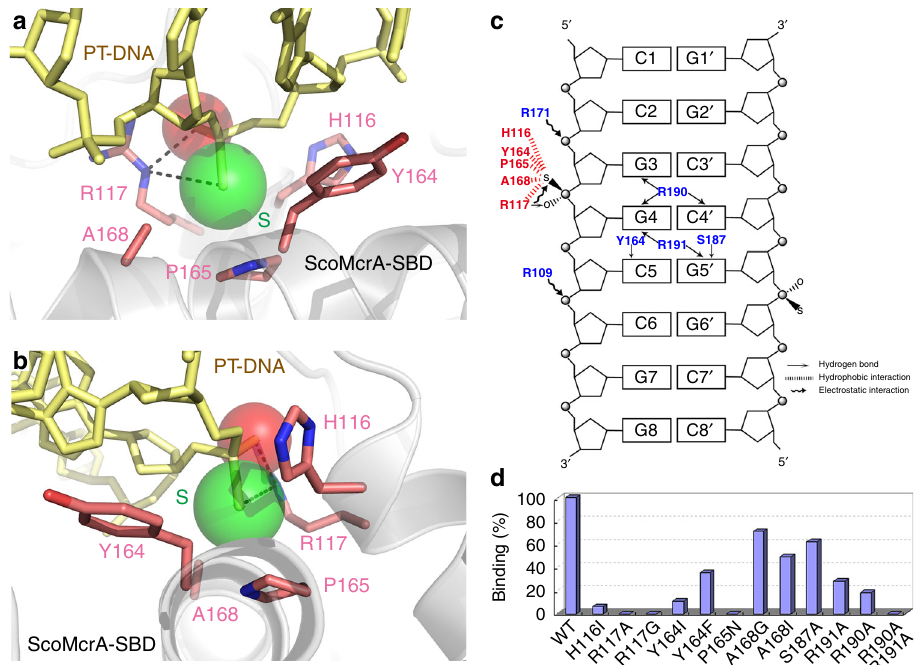
Fig. 2 Residues interacting with the sulfur atom. a Close-up view of the sulfur-binding cavity on ScoMcrA-SBD. The sulfur atom of PT-DNA is recognized by the pyrolidine ring of P165, the β -methylene groups of Y164 and H116, the β -methyl group of A168, and the γ -methylene group of R117 by hydrophobic interactions, as well as by the guanidinium group of R117 through electrostatic interaction. Electrostatic interactions are indicated as magenta dashed lines. b The view in a was rotated 90° towards left. c Schematic summary of the interactions between ScoMcrA-SBD and PT-DNA. d Mutations of key sulfur- recognizing or base-contacting residues disrupted or decreased the association between ScoMcrA-SBD and PT-DNA as analyzed by the EMSA assay. The original EMSA gels are shown in Supplementary Fig.